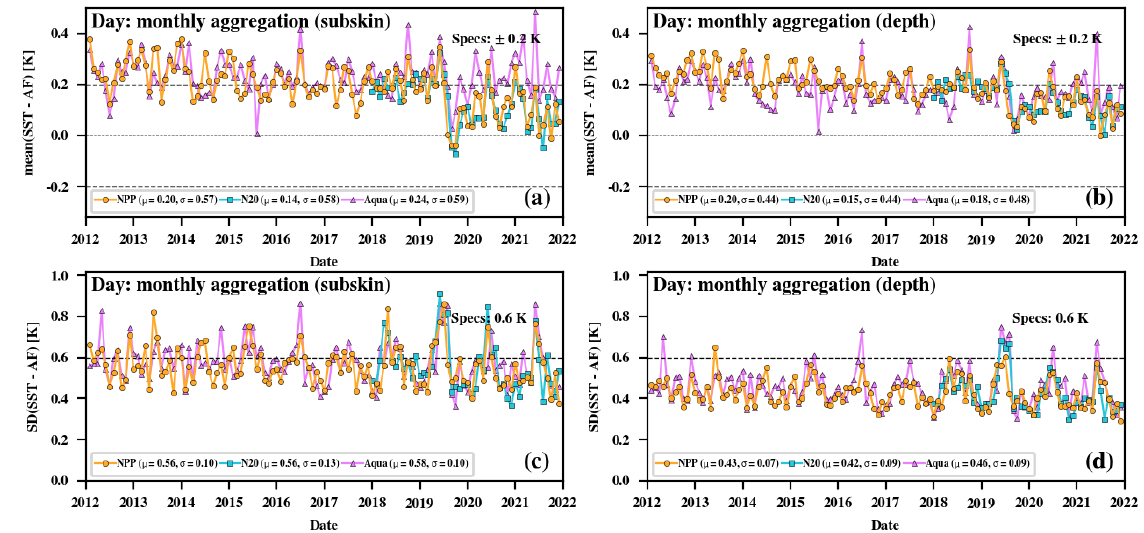
Figure 12. Panels ( a – d ) show the same results as in Figure 11 but for daytime.